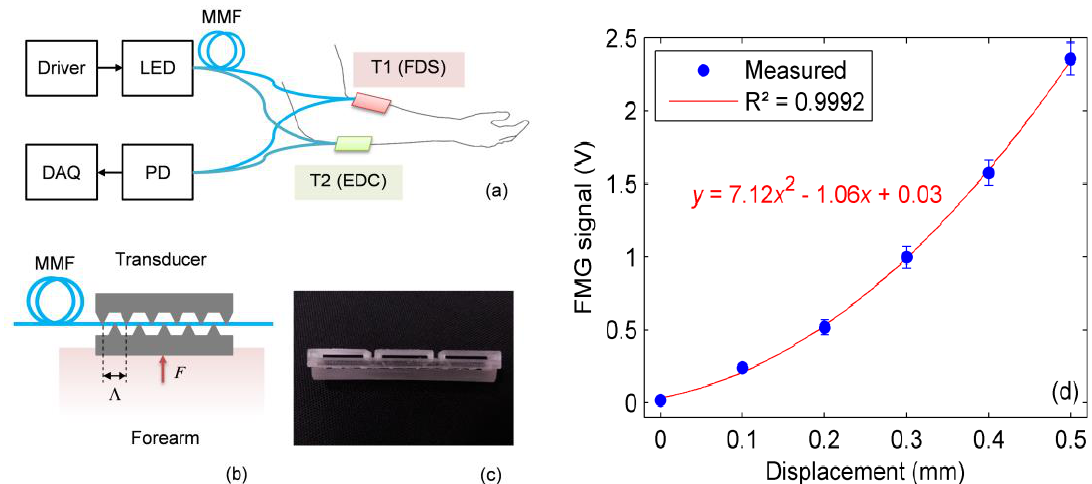
Figure 4. Optical fiber FMG sensor: ( a ) interrogation system; ( b ) force transducer and ( c ) photography of the fabricated device; ( d ) calibration curve, the red line is a quadratic curve fitting.